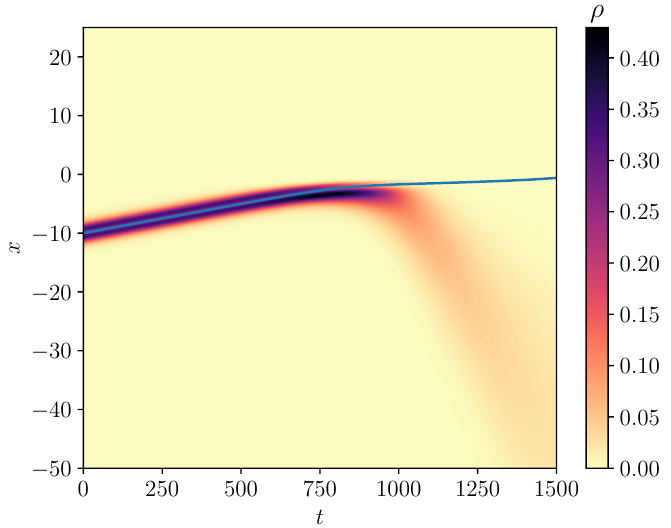
Figure 7 . Evolution of the fermion number density in spacetime as the antikink crosses the spectral wall. The fermion is reflected by the wall and decouples from the kink. The positive energy fermion is in the first excited state. β = 46 . 0